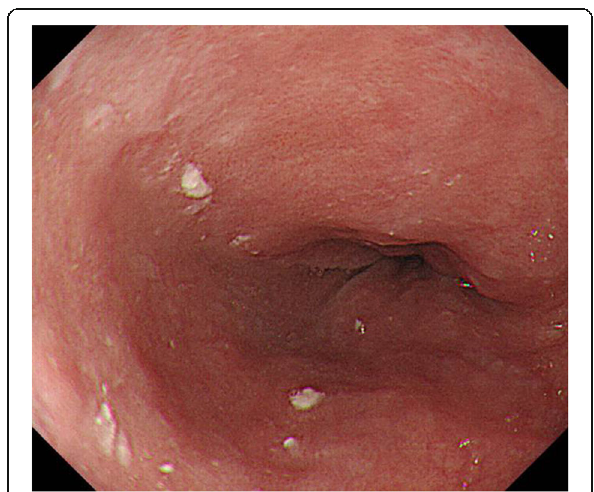
Fig. 2 Upper endoscopic examination. Esophagitis was not found in gastroesophageal junction. There is no tumor in the upper digestive